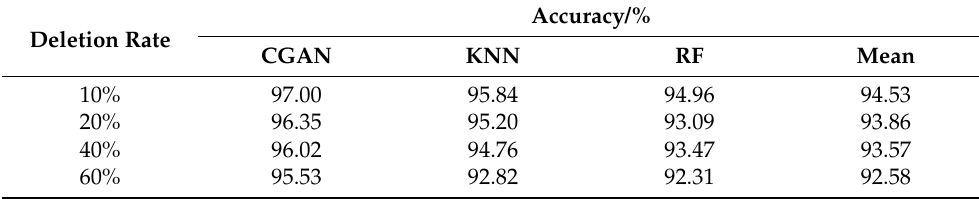
Table 4. Comparison of accuracy of reconstruction results of different models.